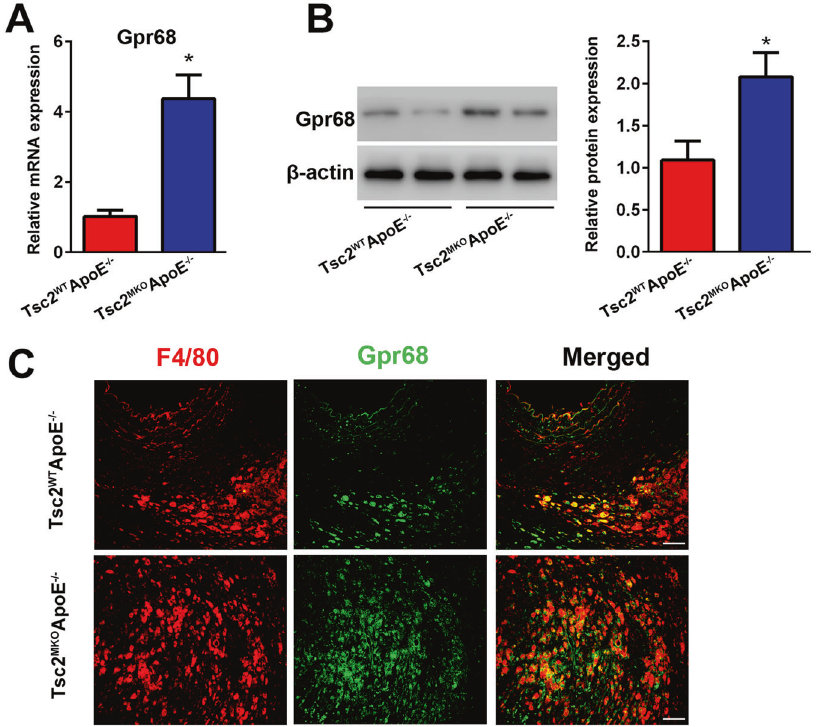
Fig. 5 Myeloid-speci fi c deletion of Tsc2 induces Gpr68 expression in AngII-infused aortas. A , B Quantitative real-time PCR ( n = 5) and western blot ( n = 4) were performed to determine the expression of Gpr68 in abdominal aortas from AngII-infused Tsc2 MKO ApoE – / – and Tsc2 WT ApoE – / – mice on day 28. C Immuno fl uorescence staining of F4/80 (red) and Gpr68 (green) in abdominal aortic tissues from AngII- infused Tsc2 MKO ApoE – / – and Tsc2 WT ApoE – / – mice on day 28 ( n = 5). Scale bar = 50 µm. * P < 0.05, vs. Tsc2 WT ApoE – / – mice infused with